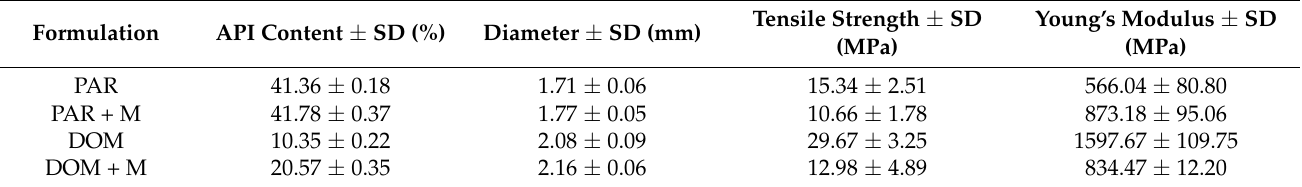
Table 2. Hot-melt extruded filaments characteristics (SD is the standard